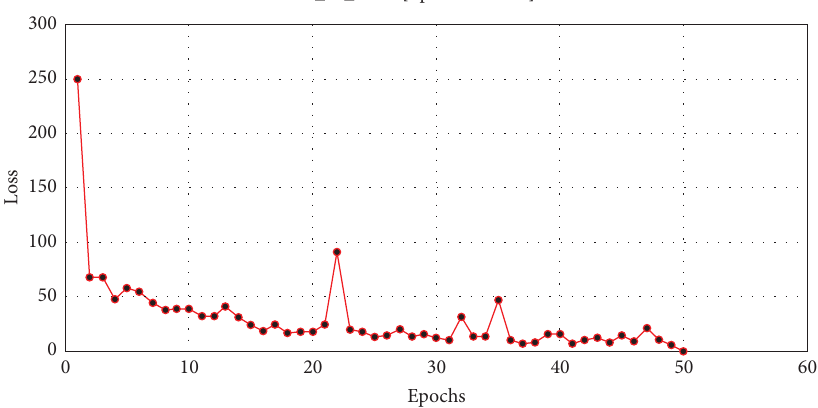
Figure 8: COVID-19 ECNN graph comparing epochs vs. loss.